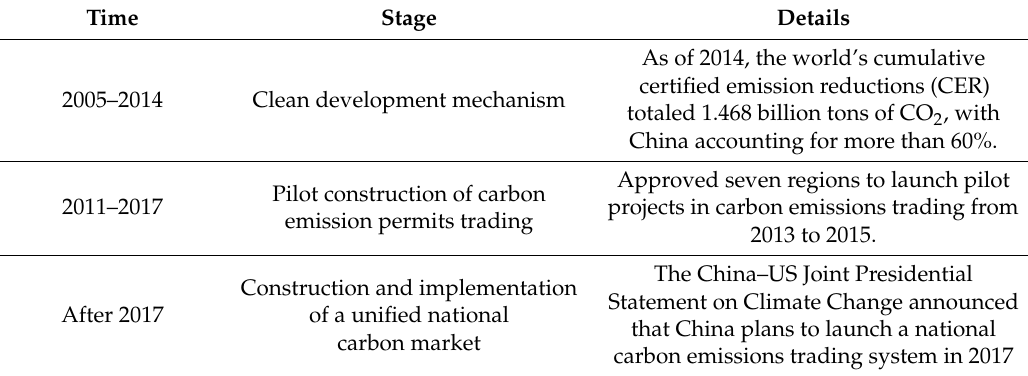
Table 3. Development process of China’s carbon market. US, the United States. Time Stage